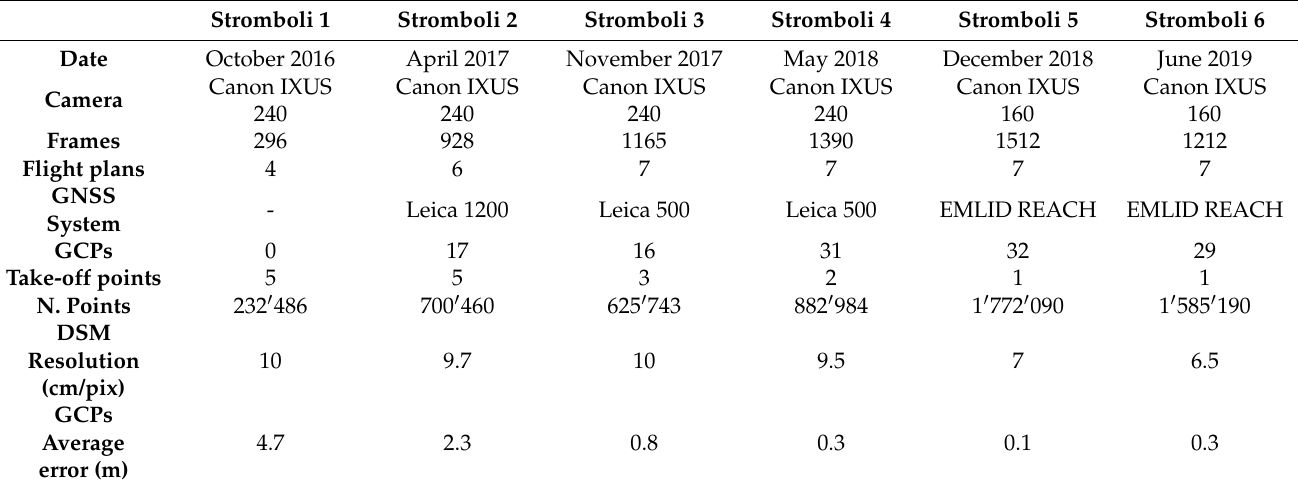
Table 1. Stromboli 1 to Stromboli 6 UAV-based photogrammetric survey specifications and product